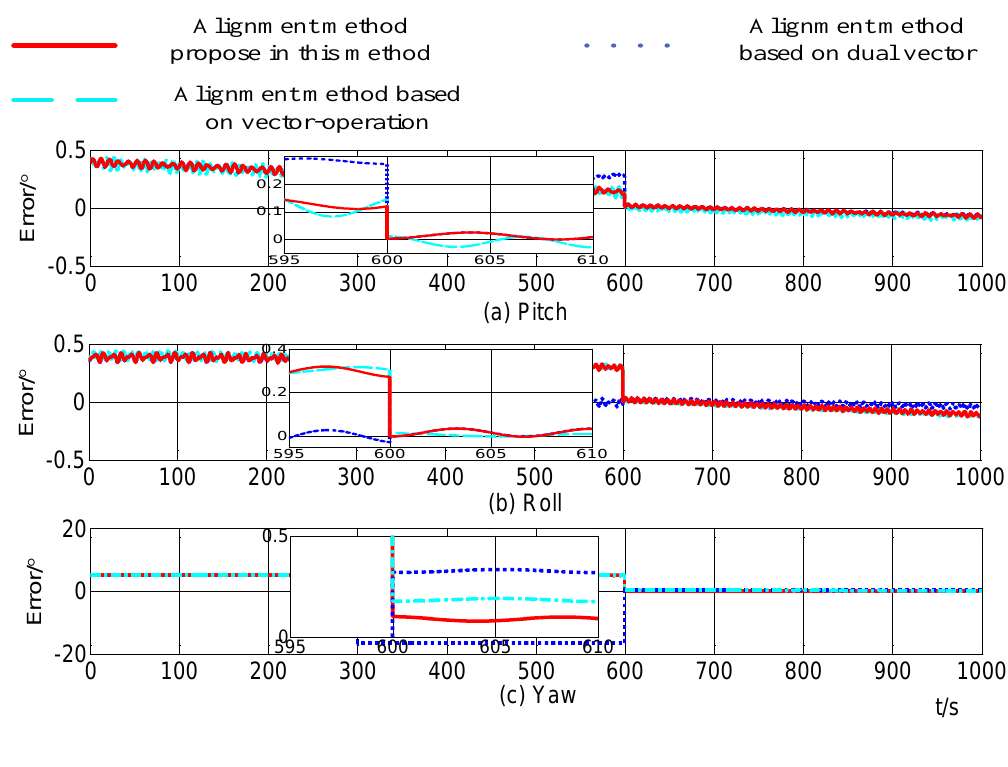
Figure 12. Alignment errors in case 2.